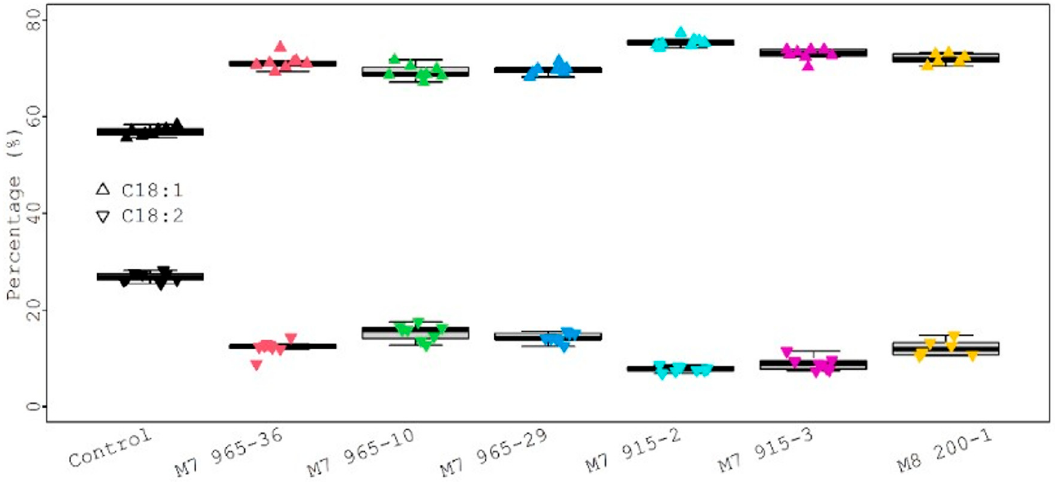
Figure 8. Comparison of oleic and linoleic between control and mutants.